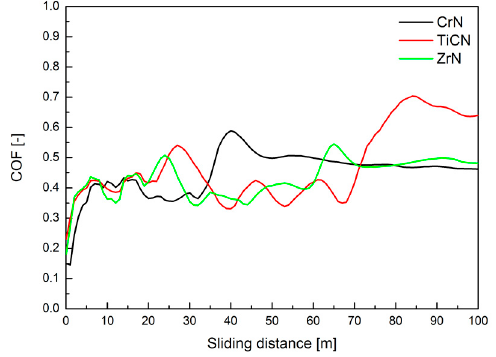
Figure 7. Average values of friction coefficient in dependence on sliding distance.